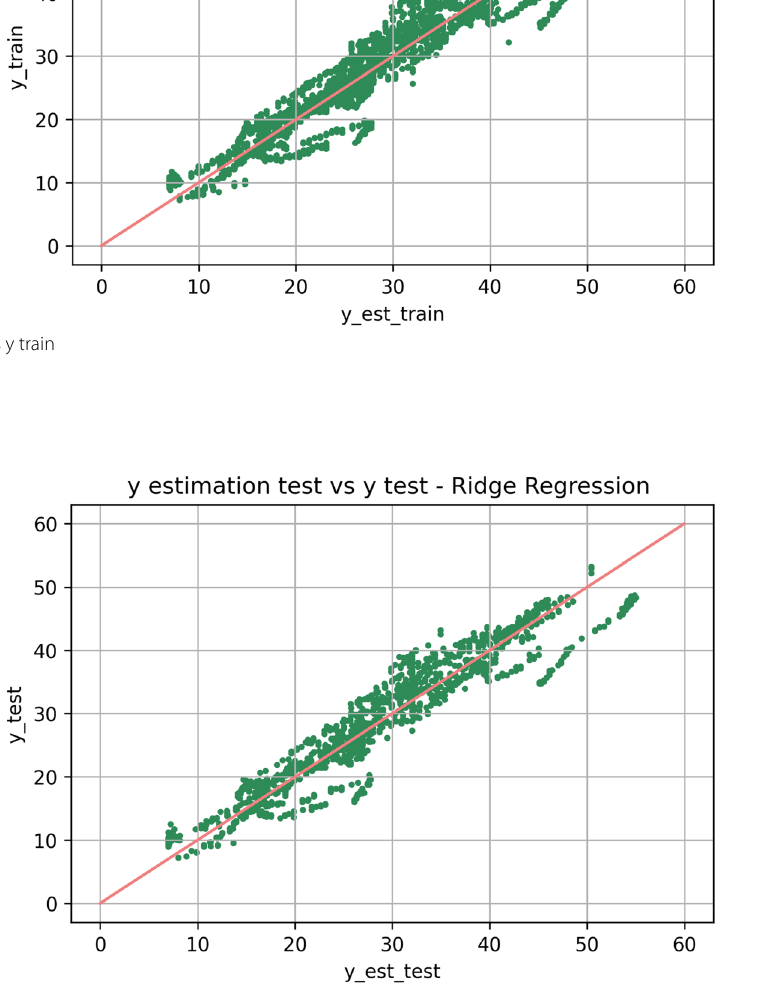
Fig. 19 y estimation test vs y